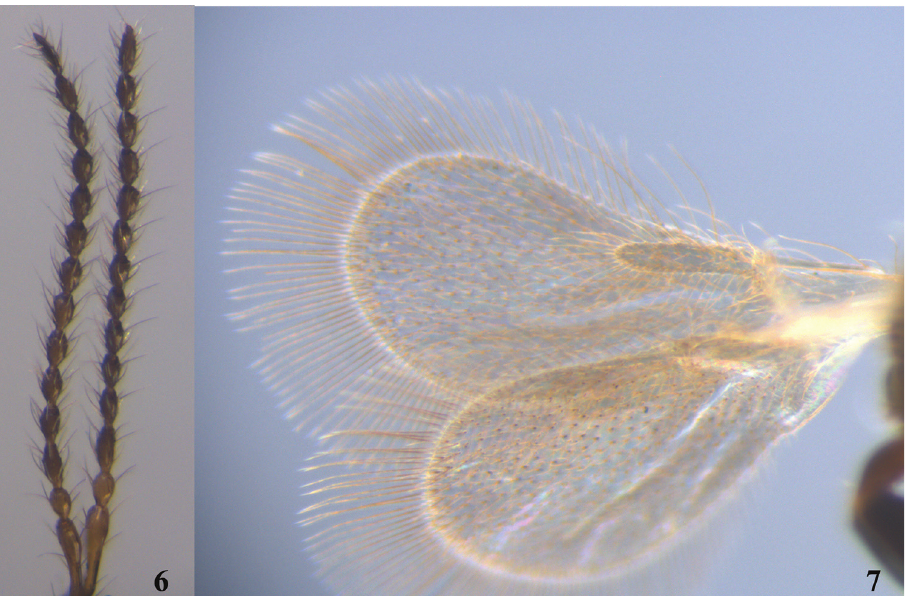
Figures 6–7. Calogalesus sinicus sp. n., ♂ , paratype. 6 Antennae 7